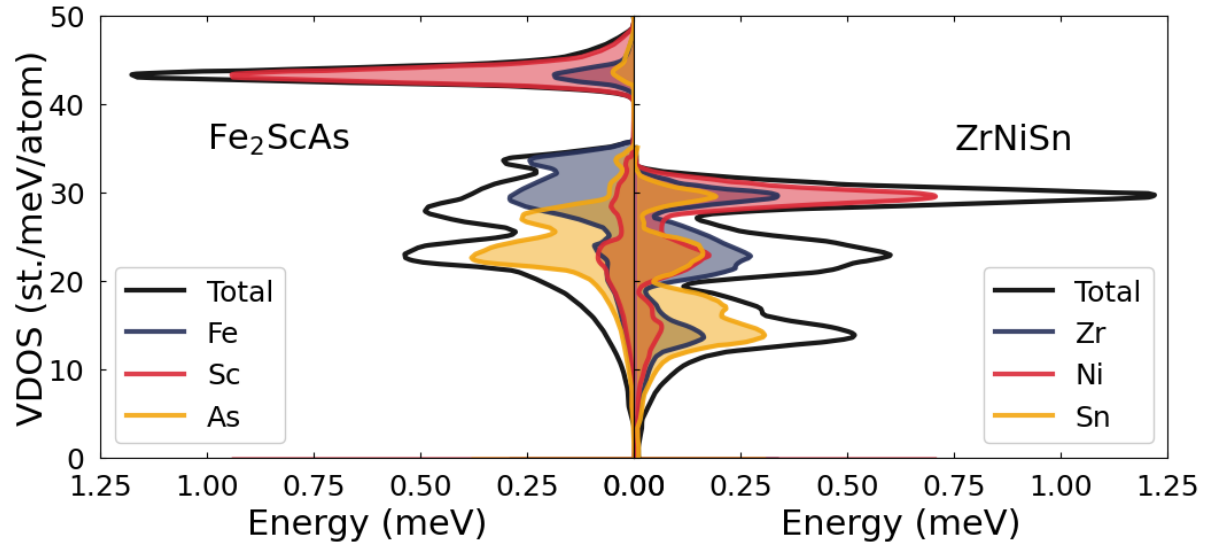
Figure 15. The phonon total DOS per unit cell and the partial DOS per atom for Fe 2 ScAs [112,117] and ZrNiSn